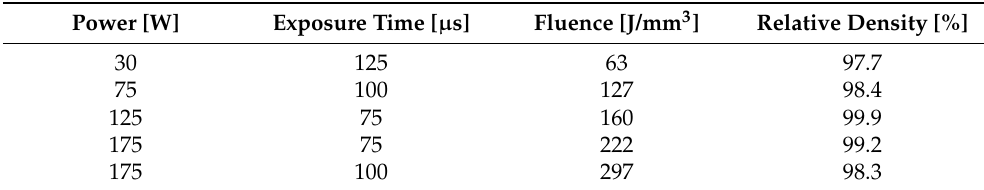
Table 2. List of fixed process parameters used for printing the NiTi cylinders. Parameters Values Scanning strategy Meander Atmosphere Argon Layer thickness 30 µ m Hatch